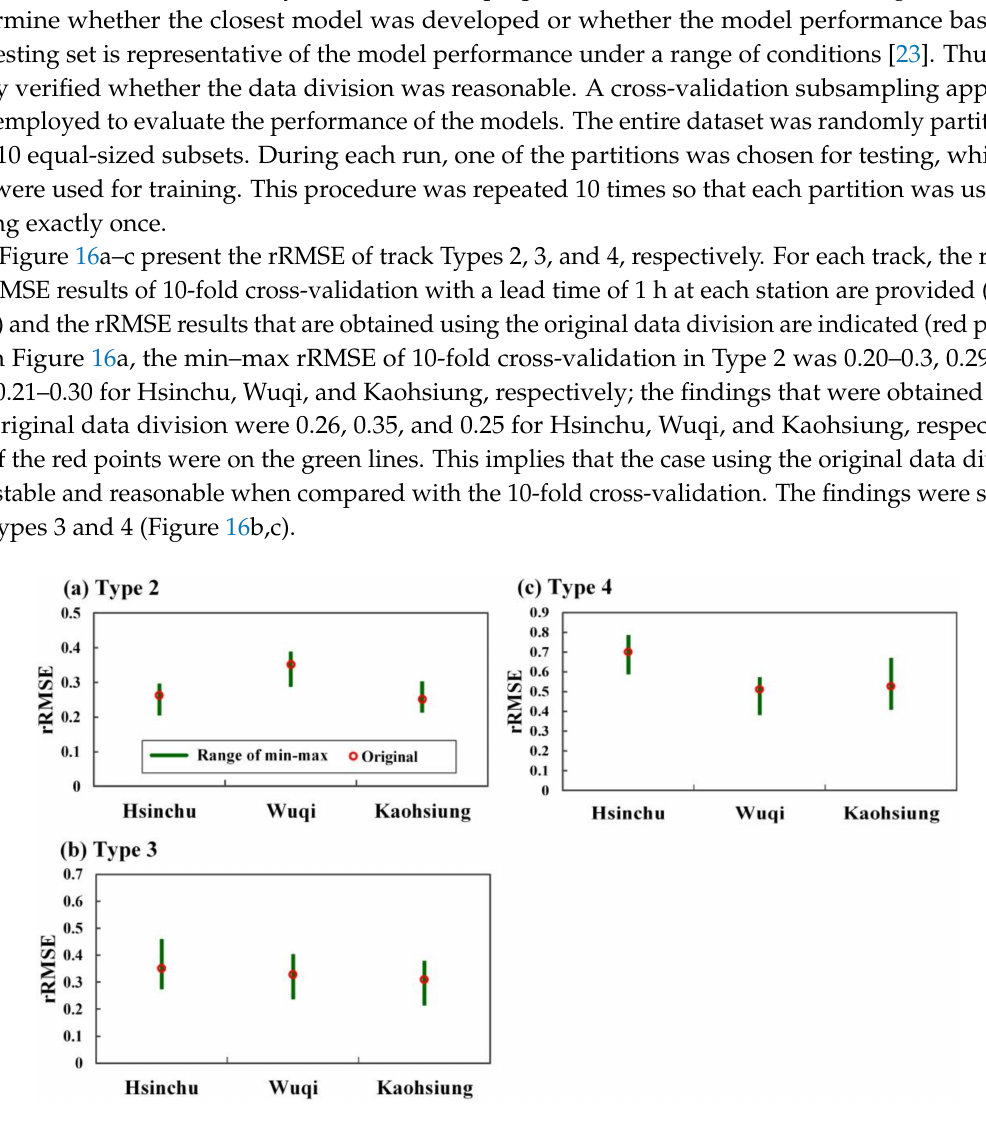
Figure 16. Range of 10-fold cross-validation and original data division (lead time = 1 h) of rRMSE at ( a ) Type 2, ( b ) Type 3, and ( c ) Type